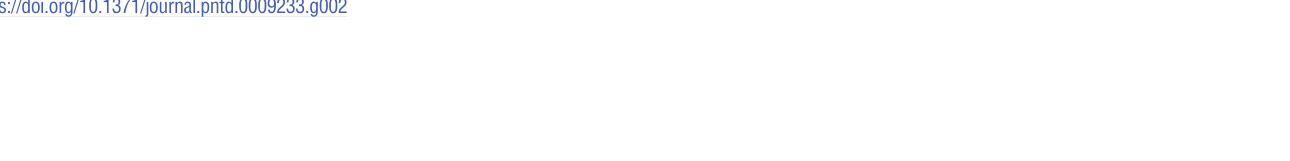
PLOS NeglectedTropical Diseases | https://doi.org/10.1371/journal.pntd.0009233 March 24,